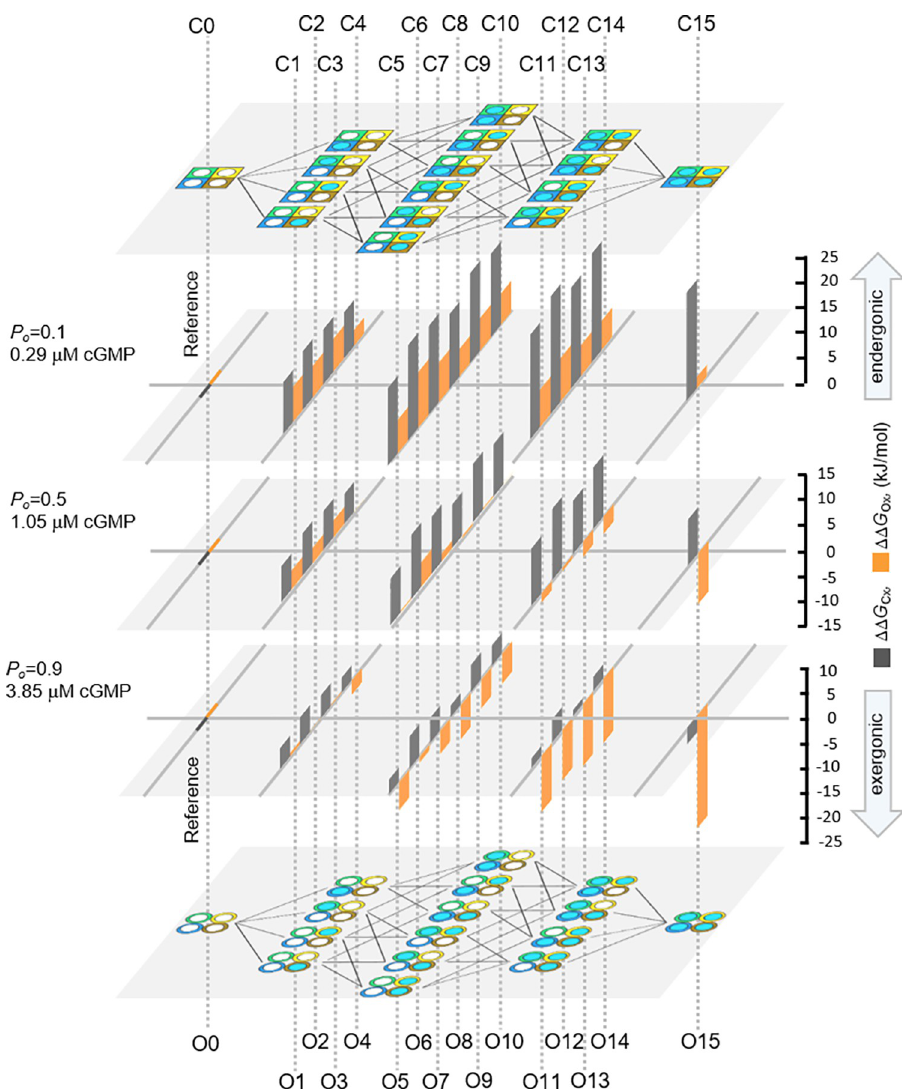
Fig 5. Energetic landscape of the activation process. Scheme with Gibbs free energies of the 16 closed (C0-C15) and 16 open (O0-O15) states and the HA model, as shown by the cartoons on the top and bottom, respectively. The bar graphs in-between provide the free energies ΔΔ G Cx and ΔΔ G Ox at three ligand concentrations, generating P o of 0.1, 0.5, and 0.9, respectively. The grey bars indicate the closed channel, the orange bars the open channel. In both cases the empty channel (C0, O0) was used as reference. The values and their errors are listed in S9 Table. Overall, an increasing values towards the open states while the subunit-specific energetic differences ligand concentration shifts the diverse E x at equal degree of liganding